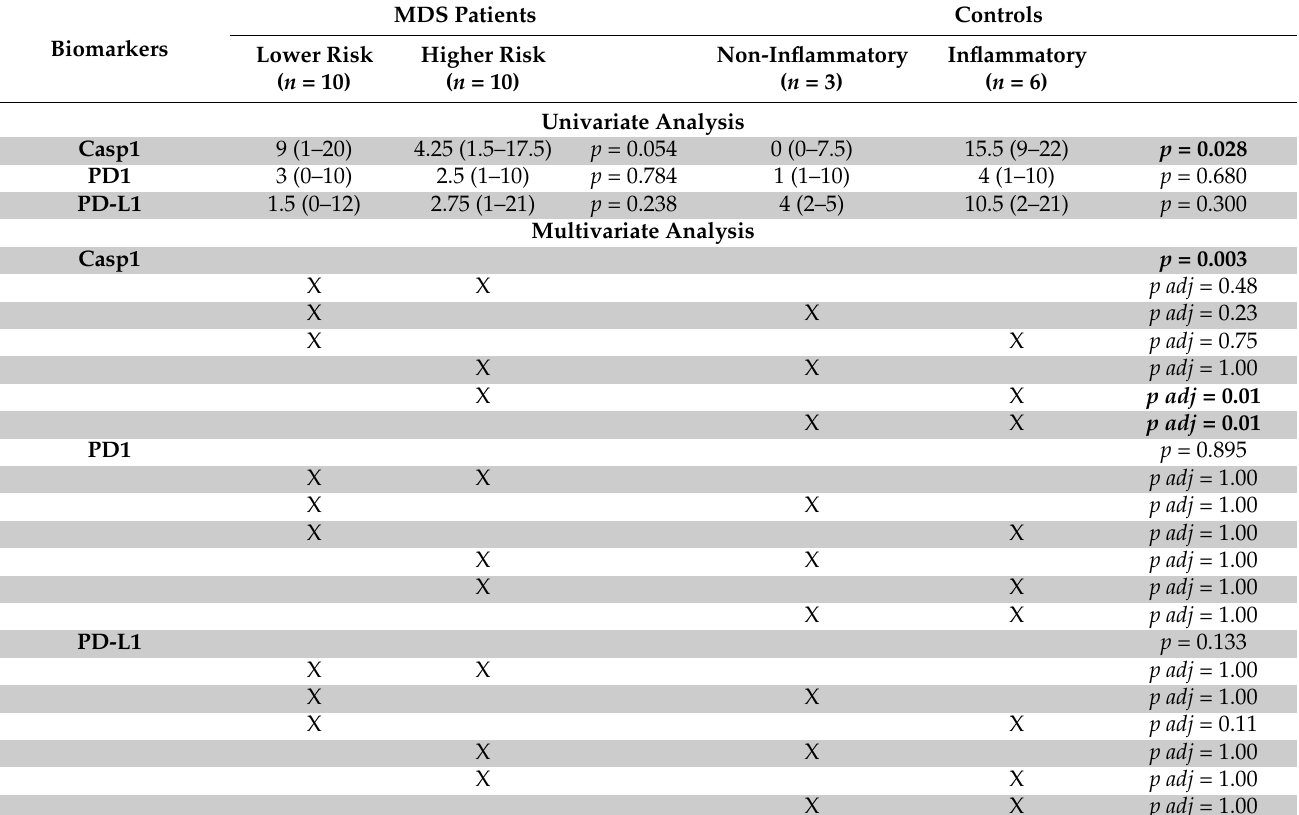
Table 2. Expression of immune-related biomarkers in MDS patients and controls.